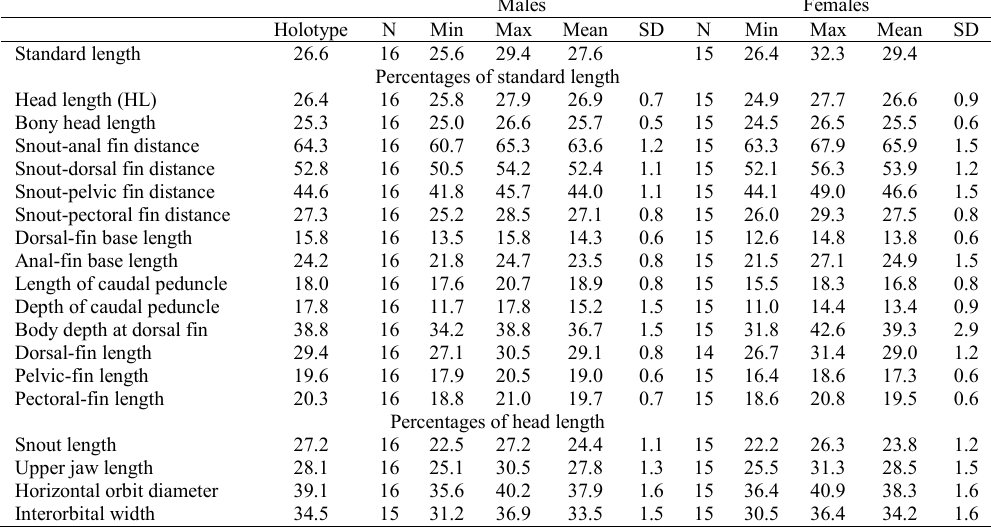
Table 1. Morphometric data for Serrapinnus potiguar . N = number of specimens; SD = Standard deviation. Male range includes the holotype.